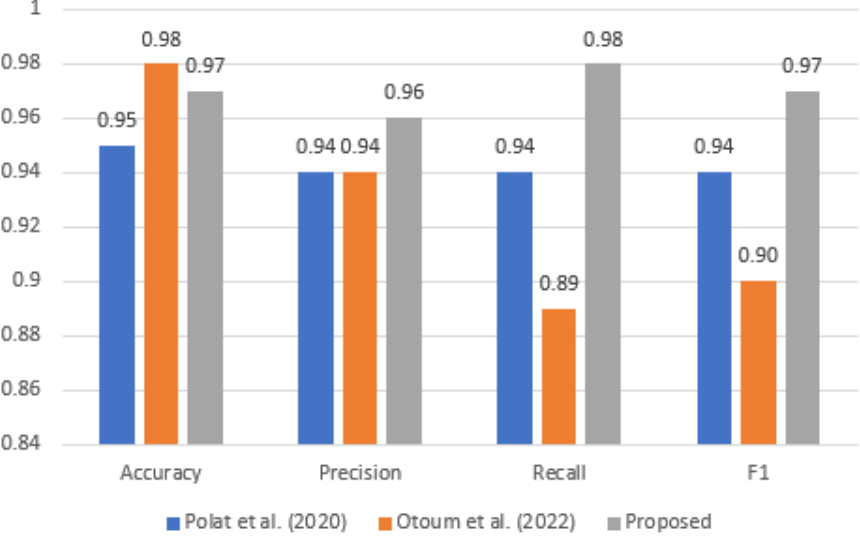
Figure 6. Comparison of our average metrics with [36] and [37].